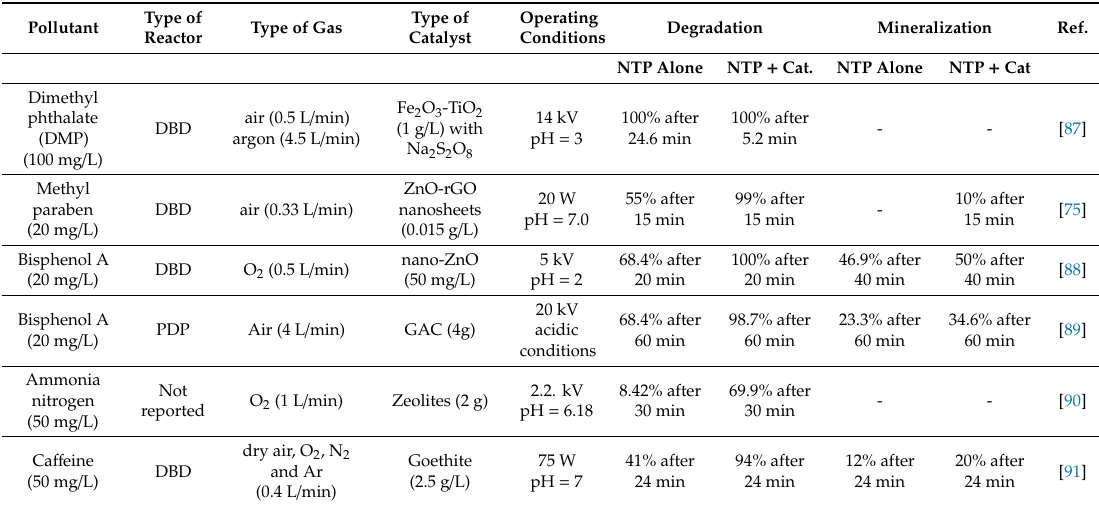
Table 3. Summary of the main operating condition and catalyst used for the degradation and mineralization of other organic pollutants in aqueous phase by NTP coupled with a